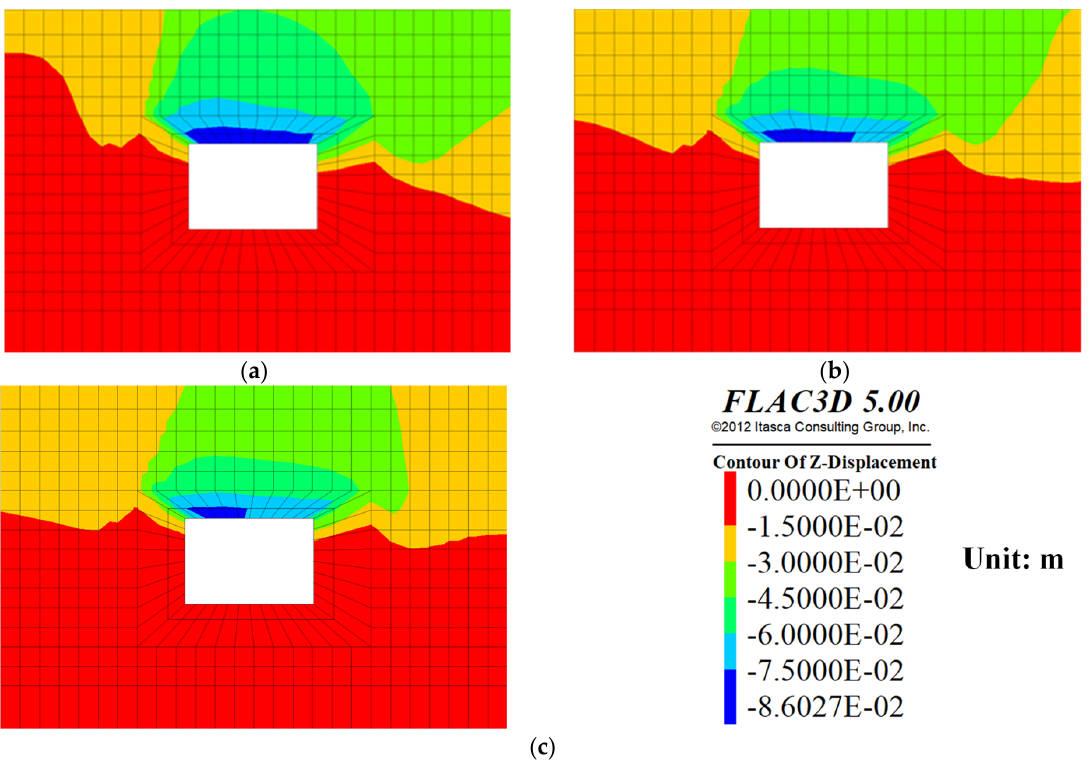
Figure 15. Vertical displacement distribution of the roof of the goaf-side entry with different yield pillar widths: ( a ) model 4 m; ( b ) model 6 m; ( c ) model 8 m.